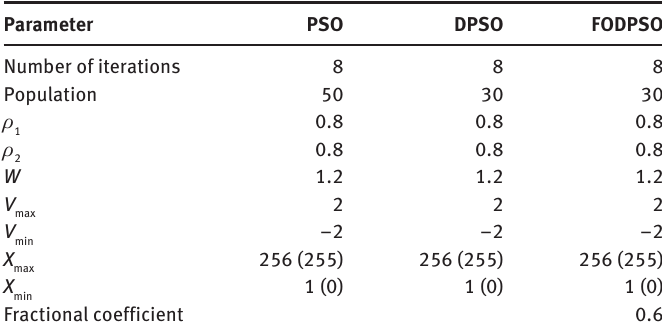
Table 4: Initial Parameters of the PSO, DPSO, and FODPSO.